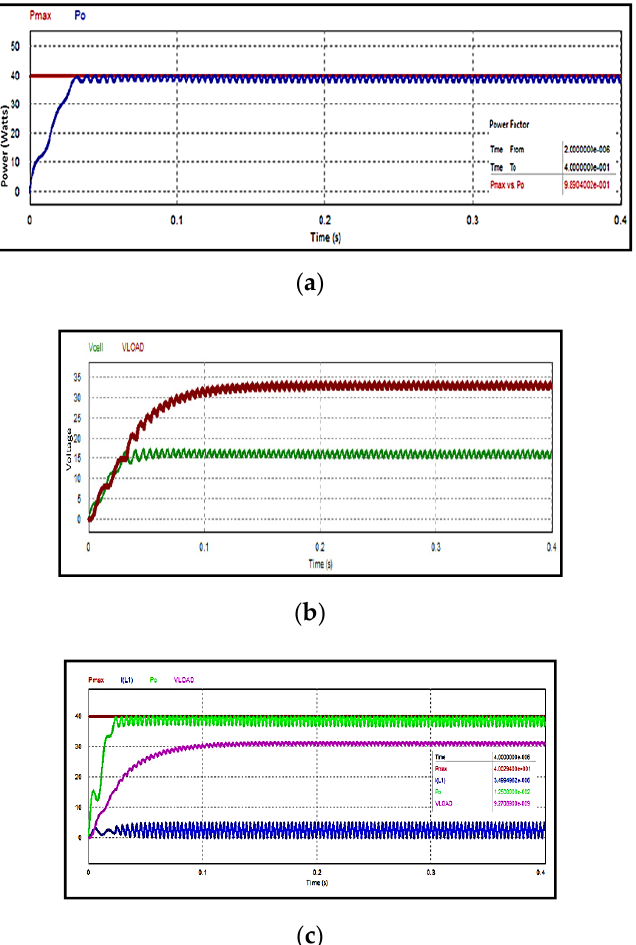
Figure 14. ( a ) Maximum power V mp vs. time; ( b ) output power Pout vs. time; ( c ) load voltage V L vs. time and load current I L vs. time.